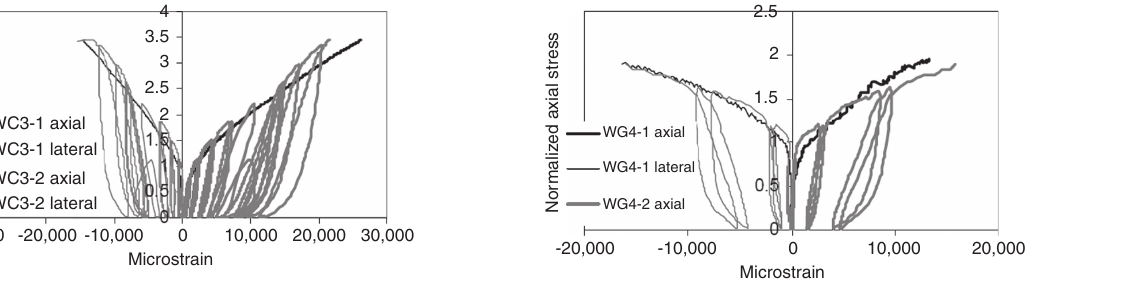
Figure 4 Stress-strain curves for WG4 specimens.